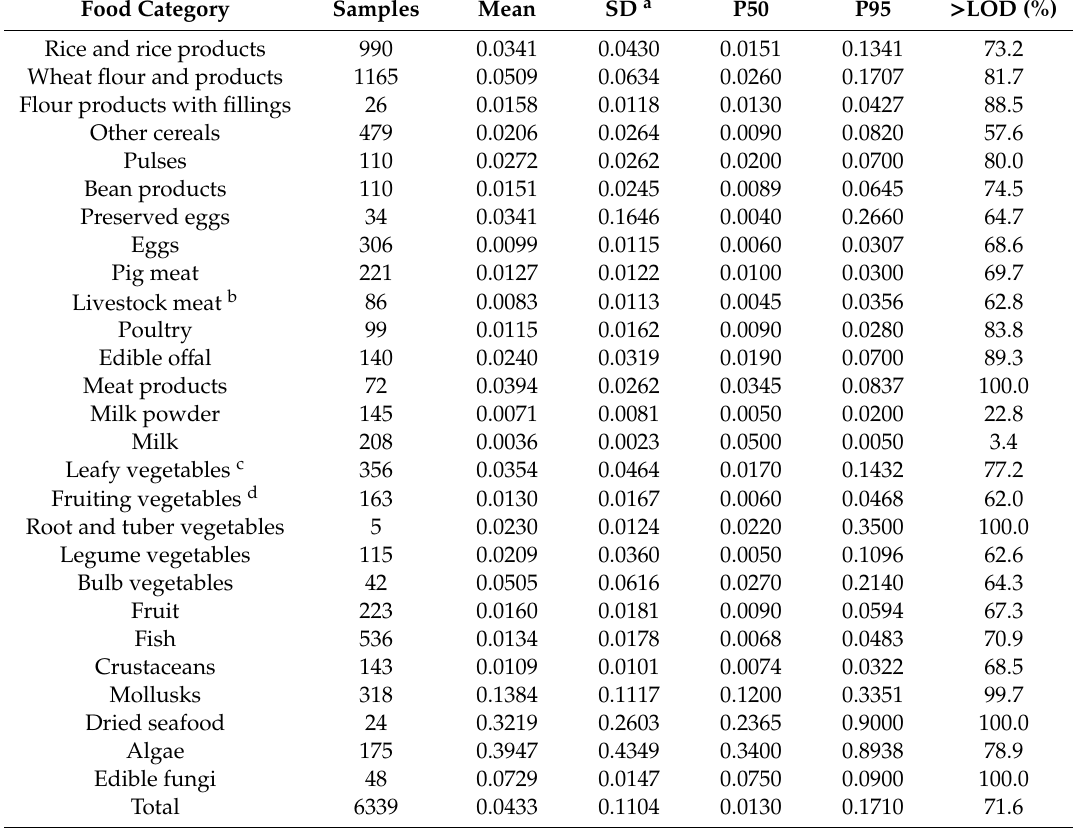
Table 2. Summary of lead concentrations in food, Guangzhou City, 2014–2017 (mg/kg).